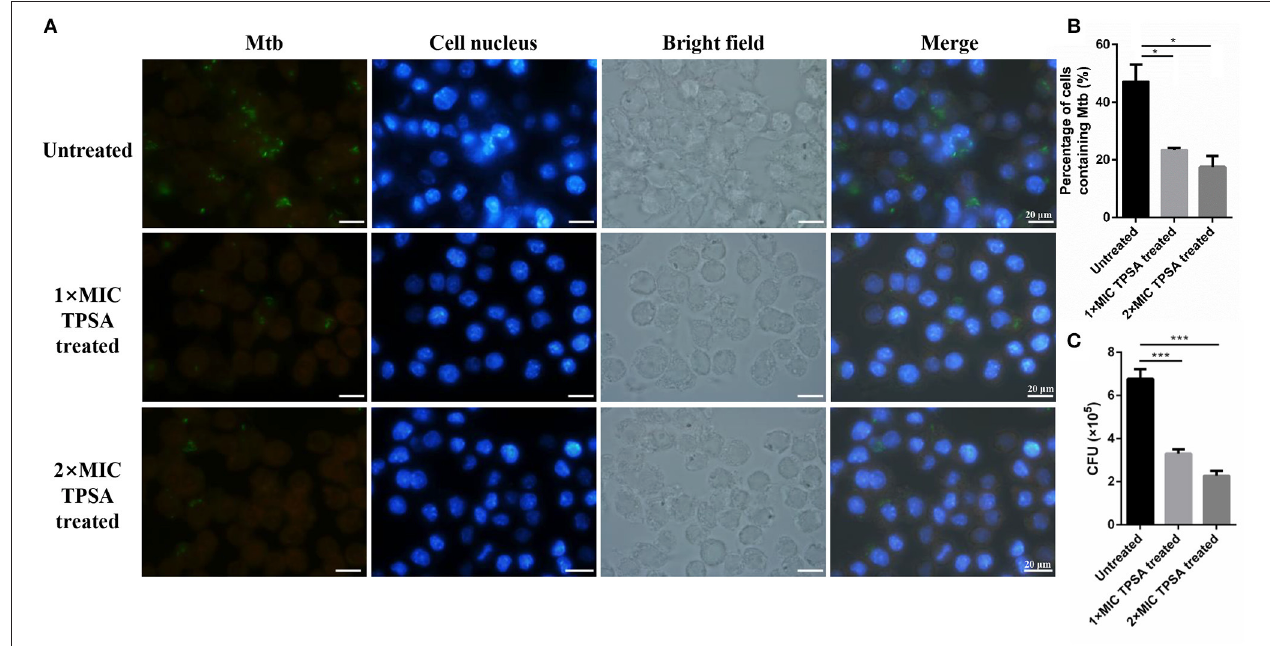
FIGURE 6 | Fluorescence microscope of RAW264.7 cells infected with H37Ra/pCG76- GFP strains (A) . Cells were infected at multiplicity of infection (MOI) of 1:10 for 4h. H37Ra in macrophage was then treated with TPSA (1 × MIC and 2 × MIC) for 24h. The green color of H37Ra/pCG76- GFP could be detected. Cell nucleus was stained with DNA-binding dye (DAPI) (blue). The percentage of cells containing H37Ra (a total of 252 cells were counted) (B) and the survival of H37Ra and H37Ra/pCG76- GFP strains in RAW264.7 cells (C) . In (B,C) , the experiment was performed in triplicate, and error bars indicate standard deviation. Differences among the groups were calculated by unpaired two-tailed t -test. The asterisks represented the statistical differences between the percentage of cells containing H37Ra or the quantity of H37Ra in the different concentrations of the TPSA-treated group. * P < 0.05; *** P < 0.001 [In (B) , the P value of the untreated group to 1 × MIC TPSA treated group is 0.02 and the P- value of the untreated group to 2 × MIC TPSA treated group is 0.0102. In (C) , the P- value of the untreated group to 1 × MIC TPSA treated group is 0.0003 and the P- value of untreated group to 2 × MIC TPSA treated group is